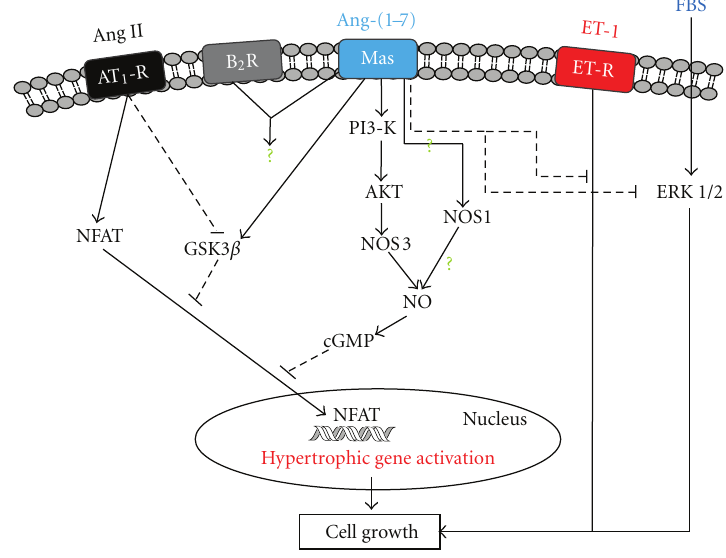
Figure 3: Ang-(1-7) signaling in cardiomyocytes. Ang-(1-7) activates the PI3-K/AKT/NOS3 pathway leading to NO generation and cGMP production. Activation of this pathway culminates with inhibition of Ang II-induced NFAT translocation. Preliminary evidence suggests that NOS1 expression may be modulated by Ang-(1-7). Ang-(1-7) also inhibits ET-1 and FBS activation of cell growth. The consequences of Ang-(1-7)/Mas and B 2 R cross-talk for cardiomyocyte function are still unknown (?). → = activation; - - (cid:3) = inhibition; ET-1 = endothelin; Ang II = angiotensin II; Ang-(1-7) = angiotensin-(1-7); ET-R = endothelin receptor; AT 1 -R = AT 1 receptor; Mas = Mas receptor; B 2 R = bradykinin receptor type 2; FBS = fetal bovine serum; NFAT = nuclear factor of activated T cells; GSK3 β = glycogen synthase kinase 3 β ; PI3-K = phosphatidylinositol 3-kinase; AKT = protein kinase B; NOS3 = nitric oxide synthase 3; NOS1 = nitric oxide synthase 1; NO = nitric oxide; cGMP = cyclic guanosine monophosphate; ERK 1/2 = extracellular signal regulated kinase 1/2. The question marks denote areas in which the current state of knowledge is still